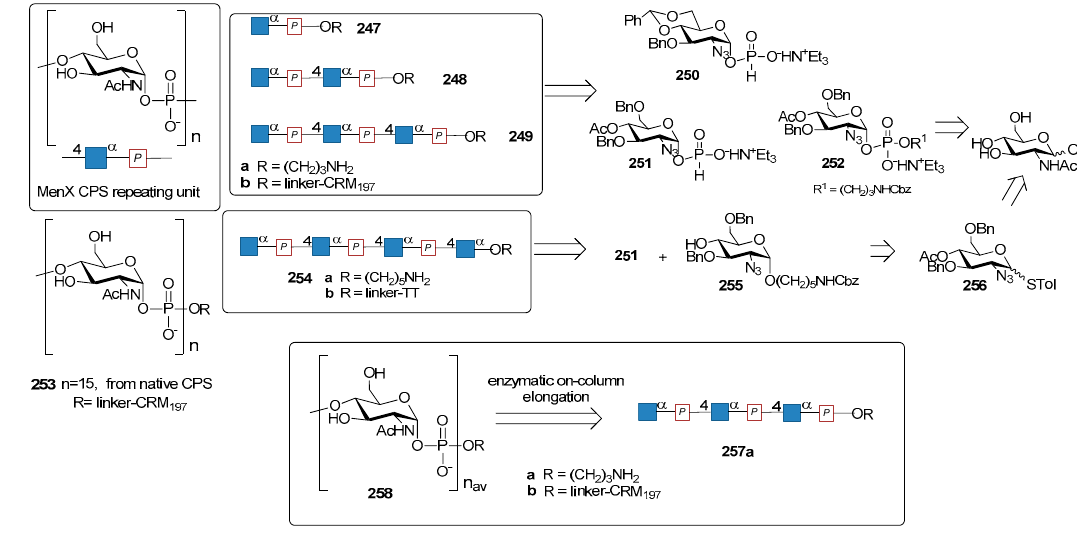
Figure 27. Repeating unit of MenX CPS and synthetic fragments reported in [200–202].